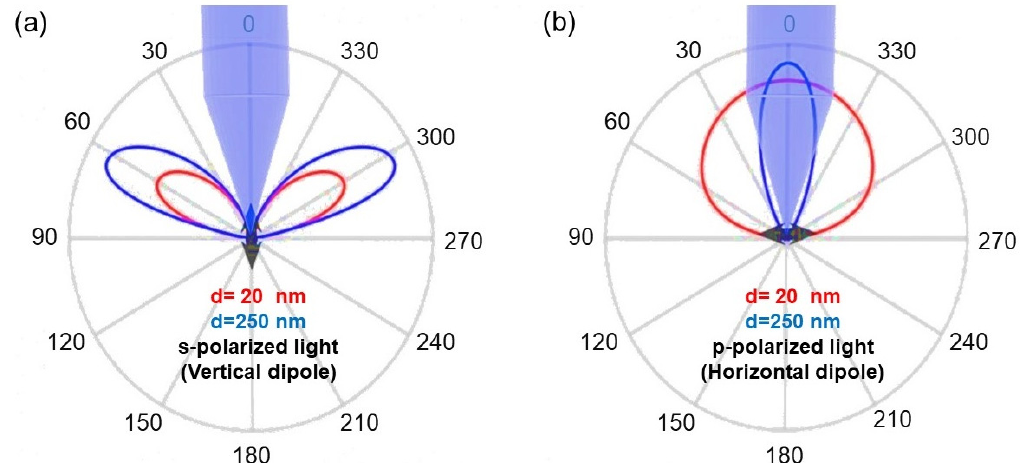
Figure 2. The angular distribution of the radiated intensity in the far-field for: ( a ) a vertically and ( b ) a horizontally oriented point dipole. The blue and red curves correspond to the thin (d = 20 nm) and thick (d = 250 nm) spacer layers, respectively, and the black double arrows show the point dipole’s orientation. The numerical aperture of the objective used for light collection is represented schematically by the blue shaded